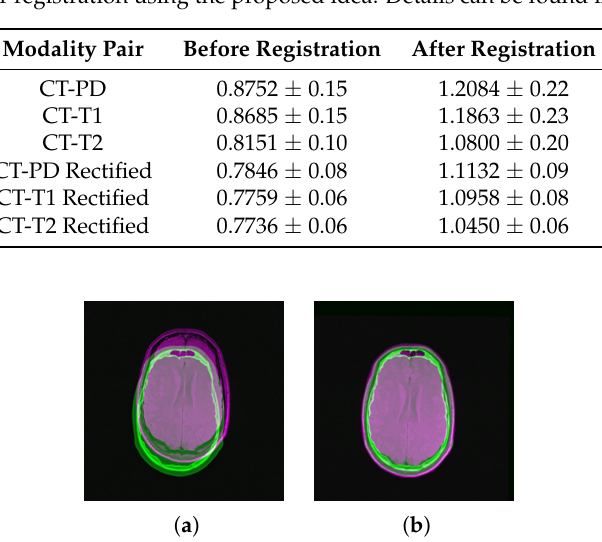
Figure 10. Pairwise display of a sample CT and PD-MRI scans from RIRE database. ( a ) Unregistered (MI = 0.8276), ( b ) Registered using the proposed transformation followed by mono-modal registration (MI =